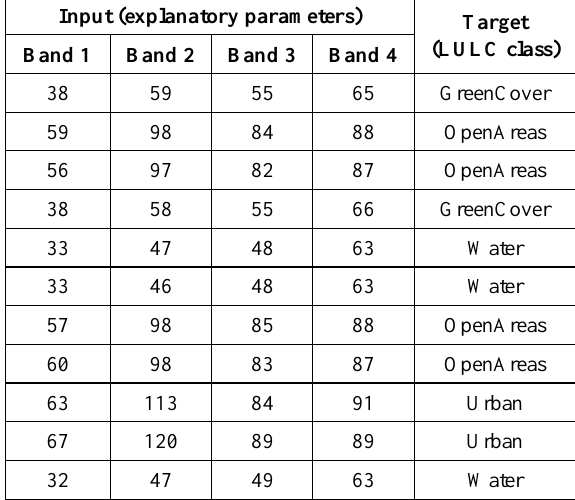
Table 1 Example part of training dataset of sample